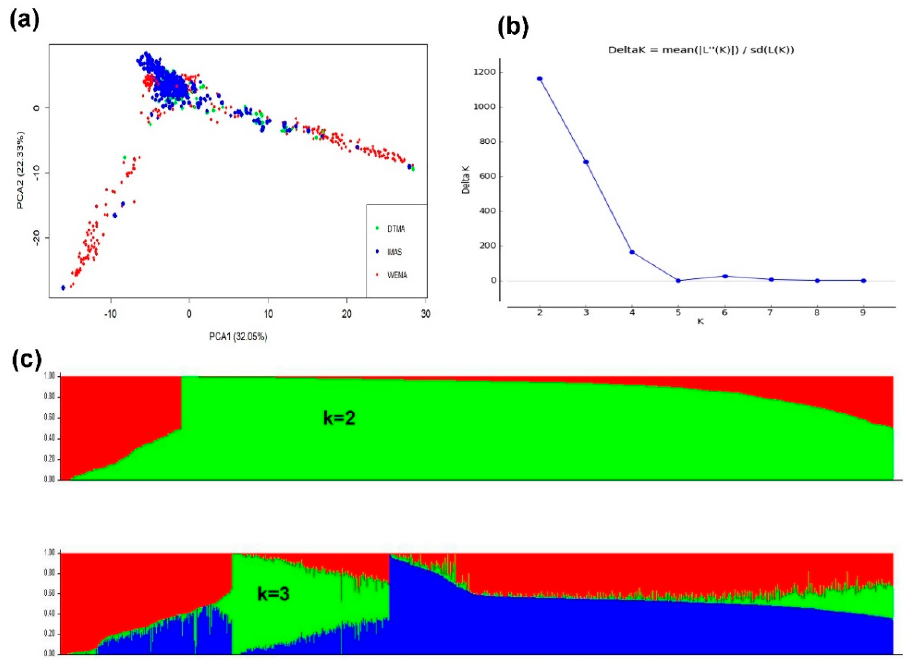
Figure 2. Population structure and PCA plot of 914 maize inbred lines estimated from 5085 SNPs. ( a ) PCA plot for the entire population and colored by the group divisions (DTMA, IMAS, and WEMA). ( b ) Plot of Delta K was calculated for K = 2 to K = 9. ( c ) Population structure of the lines for K = 2 and K = 3.